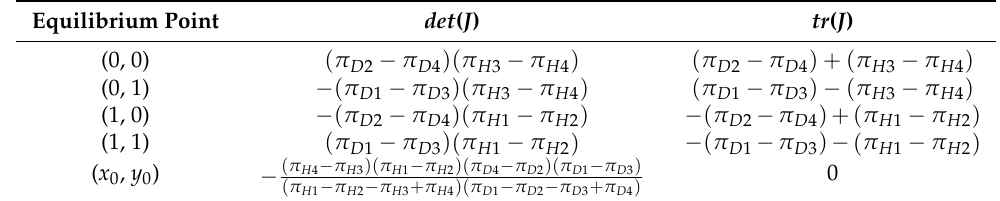
Table 3. The det ( J ) and tr ( J ) of five equilibrium points. Equilibrium